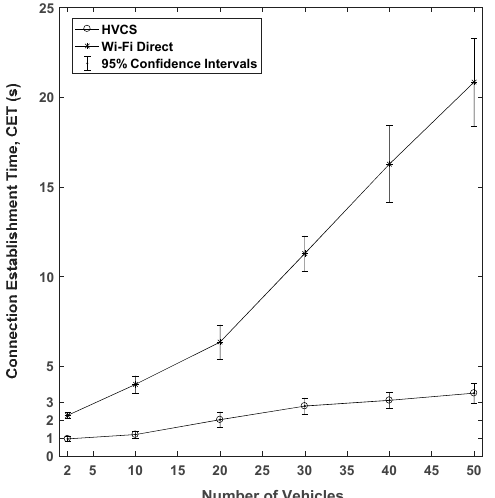
Figure 8. Comparison between the connection establishment time of the proposed HVCS and Wi-Fi Direct.